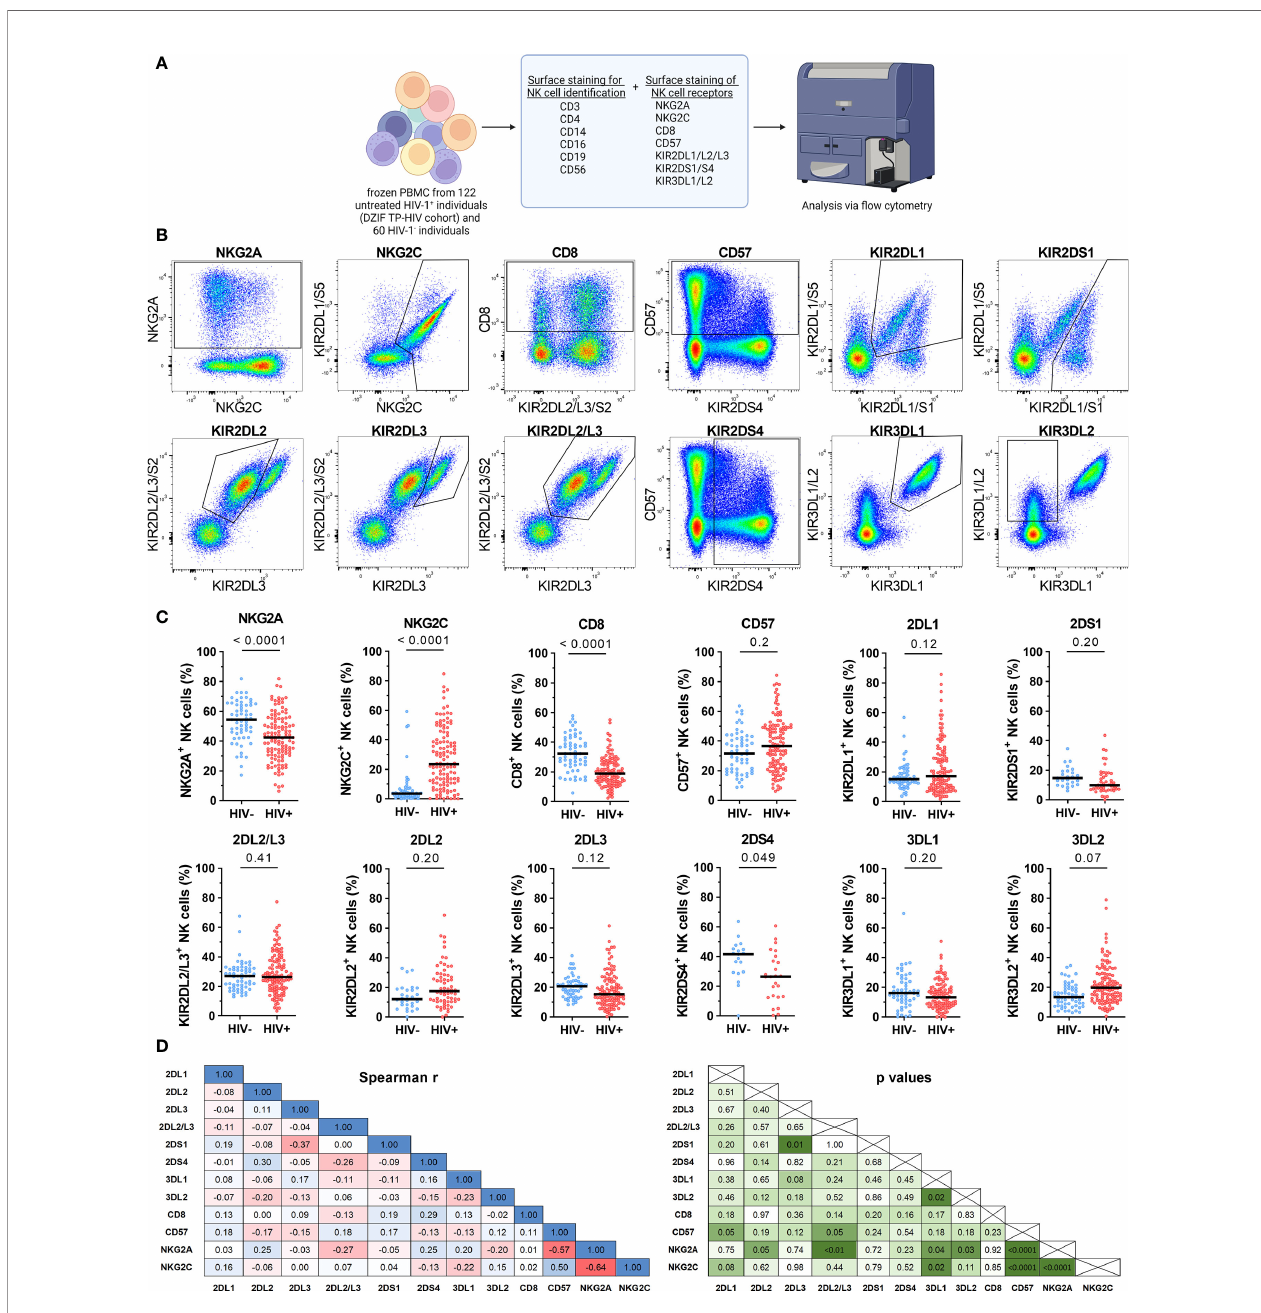
FIGURE 2 | Cell surface expression of NK cell receptors of HIV-1 - and untreated HIV-1 + individuals. (A) Overview of the fl ow cytometric assessment of NK cell receptor expression on NK cells from HIV-1 - (n = 60) and untreated HIV-1 + (n = 122) individuals. Created with BioRender.com (B) Respective expression patterns of the NK cell receptors NKG2A, NKG2C, CD8, CD57, KIR2DL1, KIR2DS1, KIR2DL2, KIR2DL3, KIR2DL2/L3, KIR2DS4, KIR3DL1 and KIR3DL2 on bulk NK cells as well as the respective gating. (C) Scatter plots displaying the percentage of NKG2A + , NKG2C + , CD8 + , CD57 + , KIR2DL1 + , KIR2DS1 + , KIR2DL2/L3 + , KIR2DL2 + , KIR2DL3 + , KIR2DS4 + , KIR3DL1 + and KIR3DL2 + cells within bulk NK cells in HIV-1 - (blue) and HIV-1 + (red) individuals. Each data point represents one donor. Donors lacking the respective gene, containing a gene deletion (KIR2DS4-del) or a null allele (KIR3DL1*004) were excluded (NKG2A/NKG2C/CD8/CD57/KIR2DL2/L3: HIV-1 - : n = 60, HIV-1 + : n = 122; KIR2DL1: n = 59, n = 118; KIR2DS1: n = 26, n = 47; KIR2DL2: n = 28, n = 64; KIR2DL3: n = 55, n = 111; KIR2DS4: n = 19, n = 25; KIR3DL1: n = 55, n = 108). (D) Correlation analyses between the frequencies of all tested receptor + NK cell subsets from HIV-1 + individuals. Left panel: r s values; right panel: p values. Data information: (C) Bars indicate the median for each group. Multiple linear regression analysis was used to determine differences between HIV-1 - and HIV-1 + individuals. (D) Spearman rank analysis. (C, D) p values were adjusted for multiple comparisons